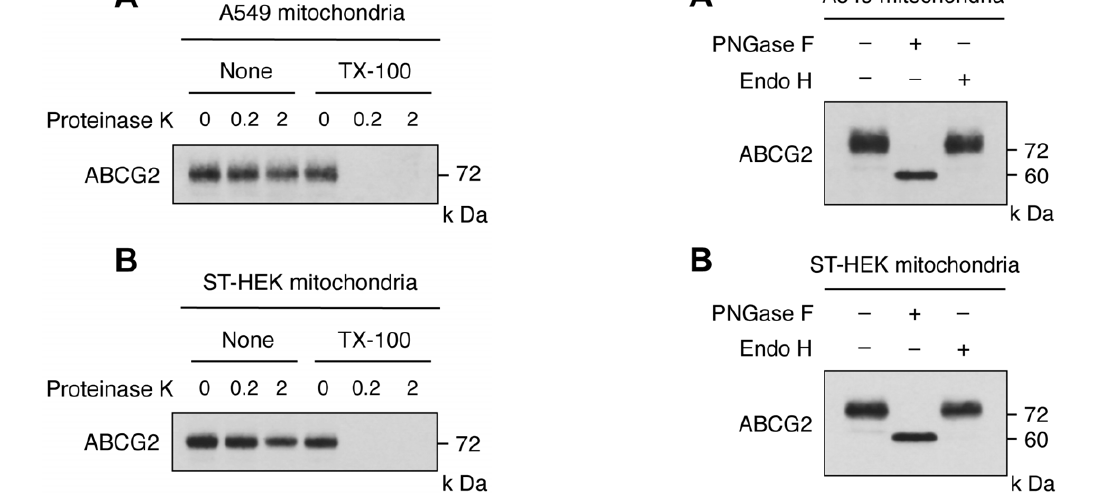
Figure 9. Identification of the ABCG2 distribution in mitochon- drial sub-compartment. Mitochondrial preparations of A549 cells (A) and ST-HEK cells (B) were treated with proteinase K on ice for 60 min in the presence or absence of 0.2% Triton X-100 (TX-100). Then the proteins were analyzed by Western blotting using a polyclonal anti- ABCG2 antibody. A representative blot of three independent experi- ments is shown.